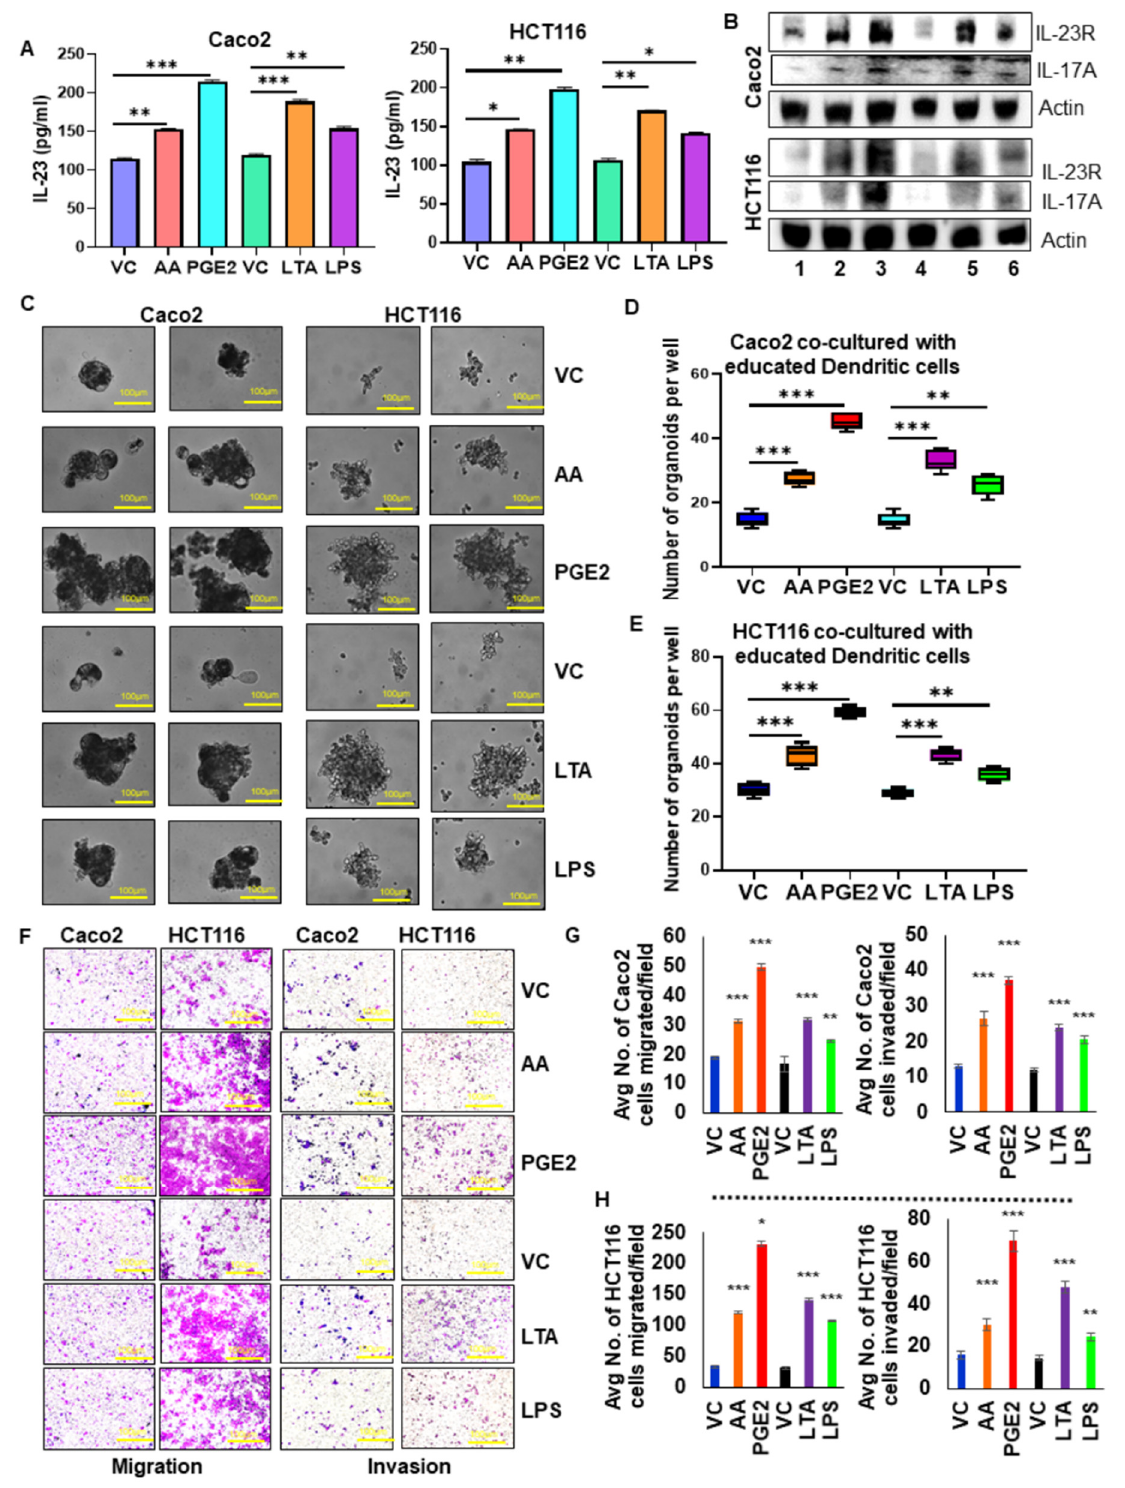
Figure 4. IL-23 production by pro-tumorigenic dendritic cells enhances colon tumor cell aggressiveness. ( A ) The level of IL-23 in the spent media of the co-culture system (Caco2/HCT116 + educated DCs with AA/PGE 2 /LTA/LPS) was measured using ELISA. ( B ) The expression of IL-23R, IL-17A were analyzed in Caco2 and HCT116 cells co-cultured with educated DCs as compared to uneducated DCs. Lane1-Vehicle control, Lane2-AA, Lane3- PGE 2 , Lane4- Vehicle control, Lane5- LTA, Lane6- LPS. Beta-actin was used as a protein loading control. ( C ) Co-culture of educated DCs with tumor cells increased the self-renewal ability of cancer cells compared with uneducated DCs co-culture system (Magnification 40×). ( D , E ) Quan- tification of organoids formed by tumor cells co-cultured with educated DCs compared to uneducated DCs. ( F ) Migration and invasion assay showed that tumor cells co-cultured with educated DCs increased migration and invasion compared